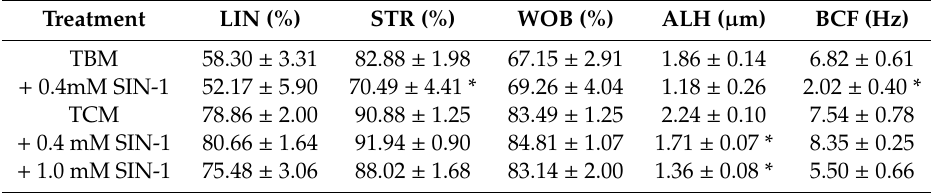
Table 1. E ff ects of SIN-1 induced-peroxynitrite in boar spermatozoa motility coe ffi cients.